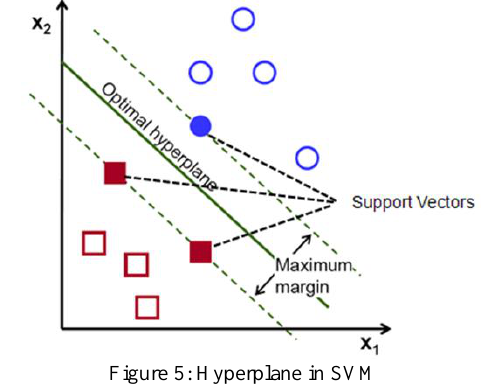
Figure 5: Hyperplane in